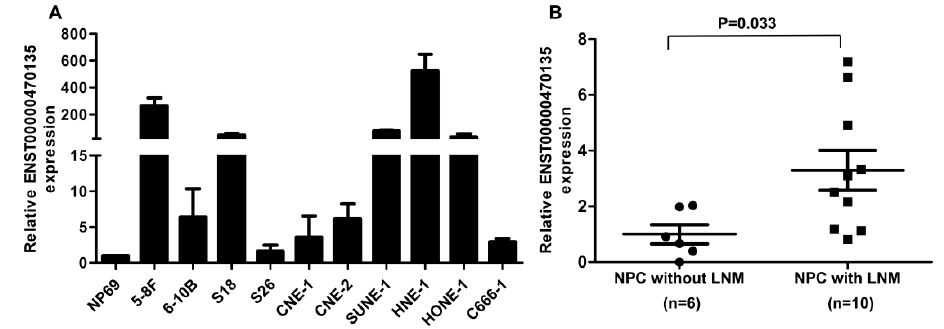
Figure 3. Validation of significantly dysregulated lncRNAs by qRT-PCR. The figure shows the expression patterns of 22 lncRNAs including 11 upregulated ( A ) and 11 downregulated ( B ) were consistent with the microarray data.